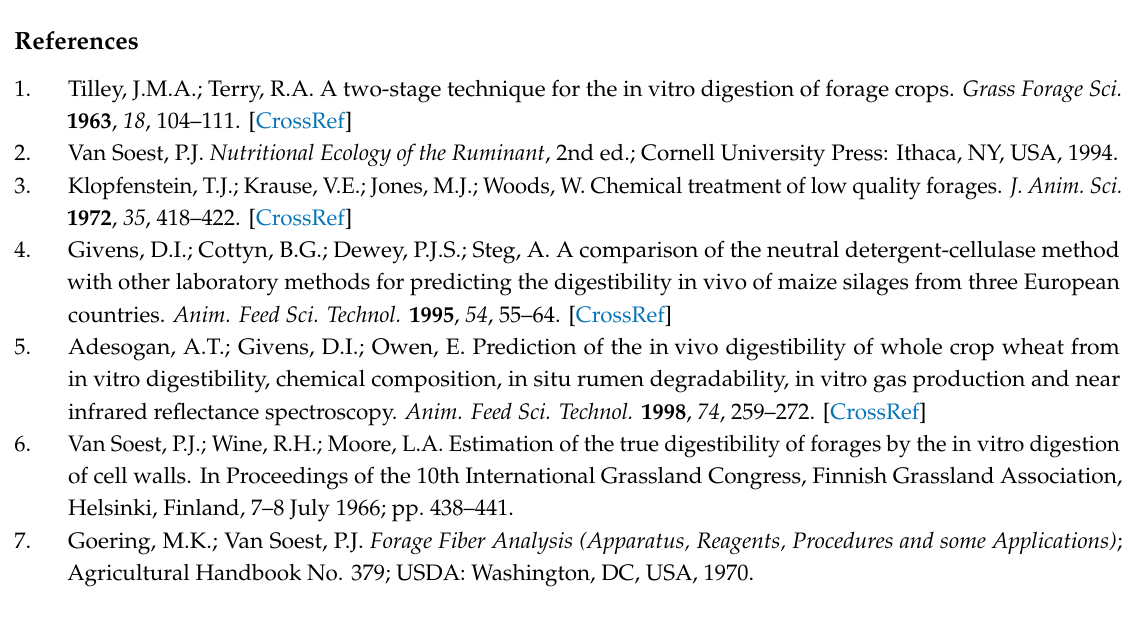
Table S1: Practical recommendations on the use of the Ankom Daisy II incubator (AD II ), Table S2: Variability (CV, %) of the Ankom Daisy II incubator (AD II ) after 48 h of incubation, Table S3: Linear equation between the Ankom Daisy II incubator (AD II ) at 48 h and other digestibility systems, Table S4: Acronyms for digestibility